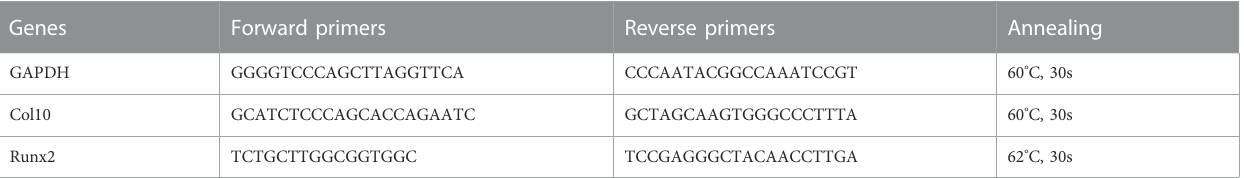
TABLE 1 Primer used for a real-time quantitative polymerase chain reaction.